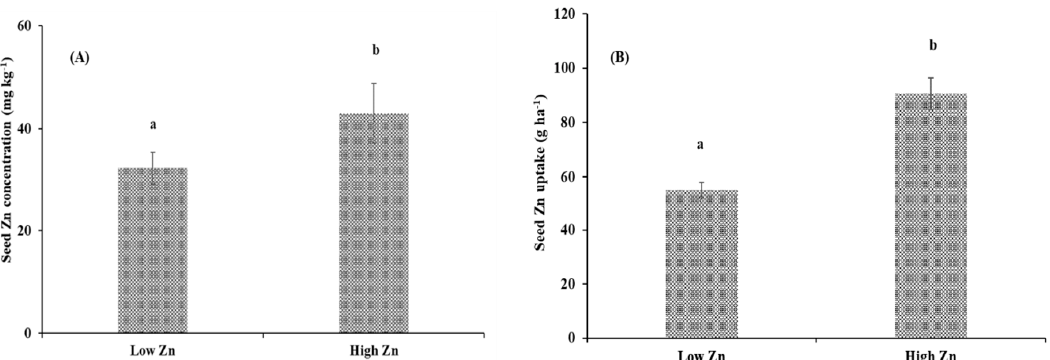
Figure 3. Mean values of ( A ) seed zinc (Zn) concentration (mg kg − 1 ) and ( B ) seed Zn uptake (g ha − 1 ) of pigeonpea genotypes grown under low and high Zn treatments. Error bars indicate standard deviation of genotypes. Two means having different letters differ significantly. Table 4. Pearson’s correlation coe ffi cients showing relations among plant height, branches plant − 1 , pods plant − 1 , seeds plant − 1 , 100 seed weight, seed yield, seed zinc (Zn) concentration, and seed Zn uptake of pigeonpea genotypes (n = 38). *, ** denote significant at p < 0.05 and p < 0.01,